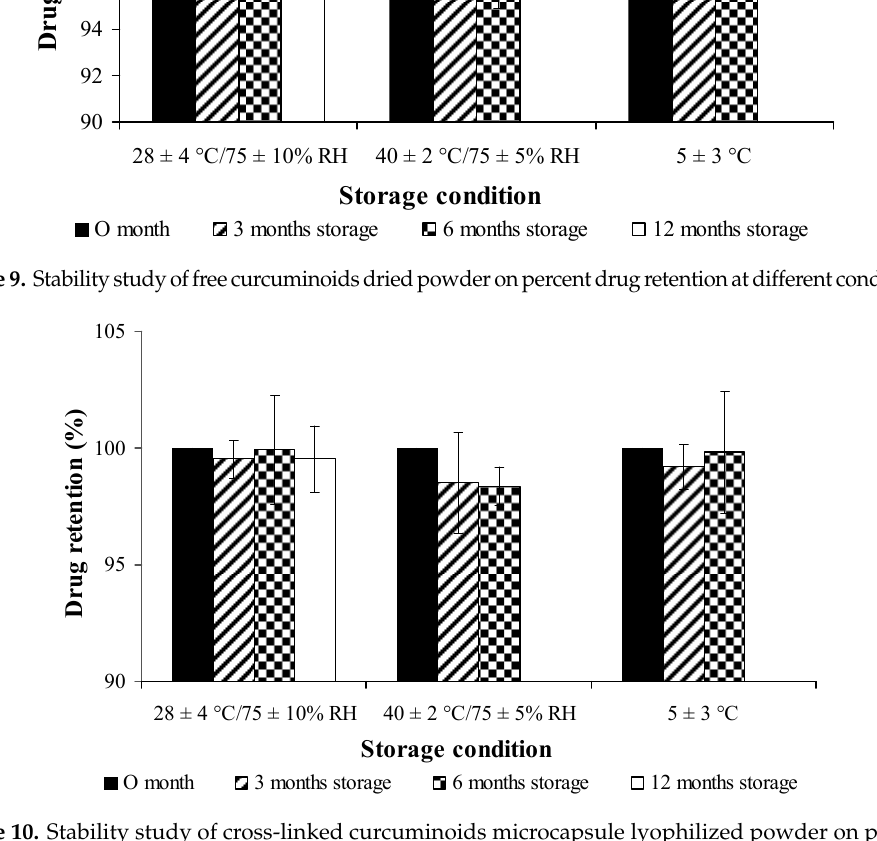
Figure 10. Stability study of cross-linked curcuminoids microcapsule lyophilized powder on percent drug retention at different conditions.